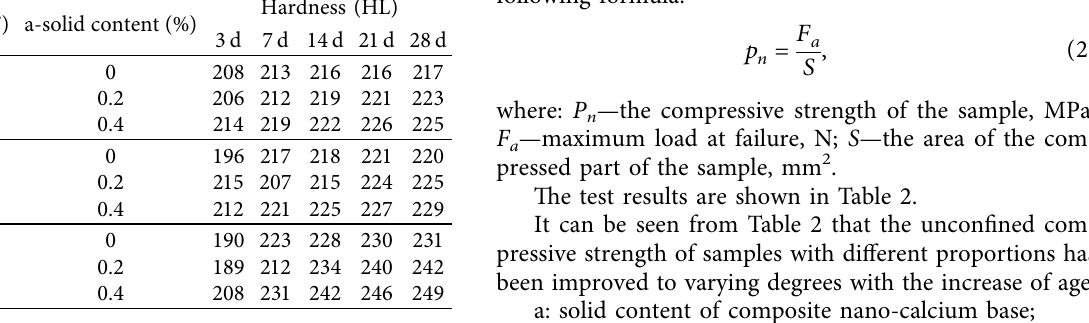
Figure 3(b): the hardness of 1.65 g/cm 3 sample varying with age; Figure 3(c): the hardness of 1.75 g/cm 3 sample varying with age; Figure 3(d): the hardness curve of each group of samples after 28 d.